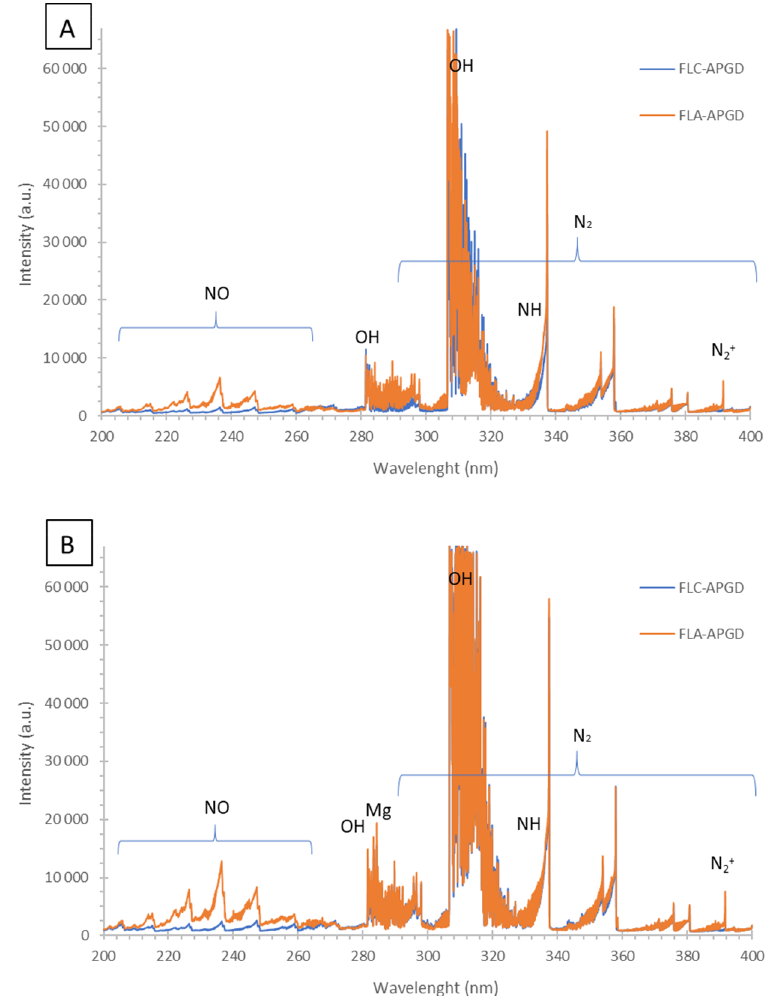
Figure 5. The emission spectra of ( A ) the aqueous P. ginseng root extract and ( B ) the aqueous G. biloba leave extract during their activation either by FLA-dc-APGD or FLC-dc-APGD.